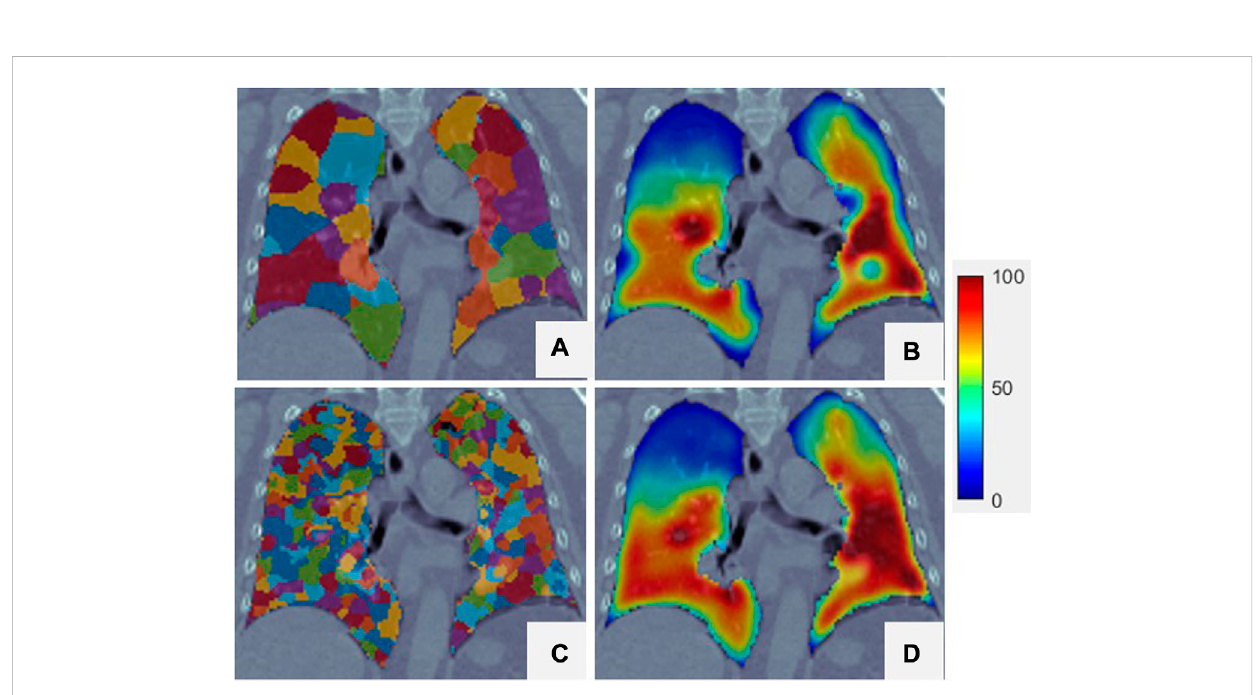
FIGURE 6 Two different super-voxel segmentations with different K init and the corresponding CTVI SVD . The K init of the top row is 500, and the bottom row is 120000. (A,C) are the results of the super-voxel segmentation in the lung region. (B,D) are the CTVI SVD of the lung region superimposed onto the CT.